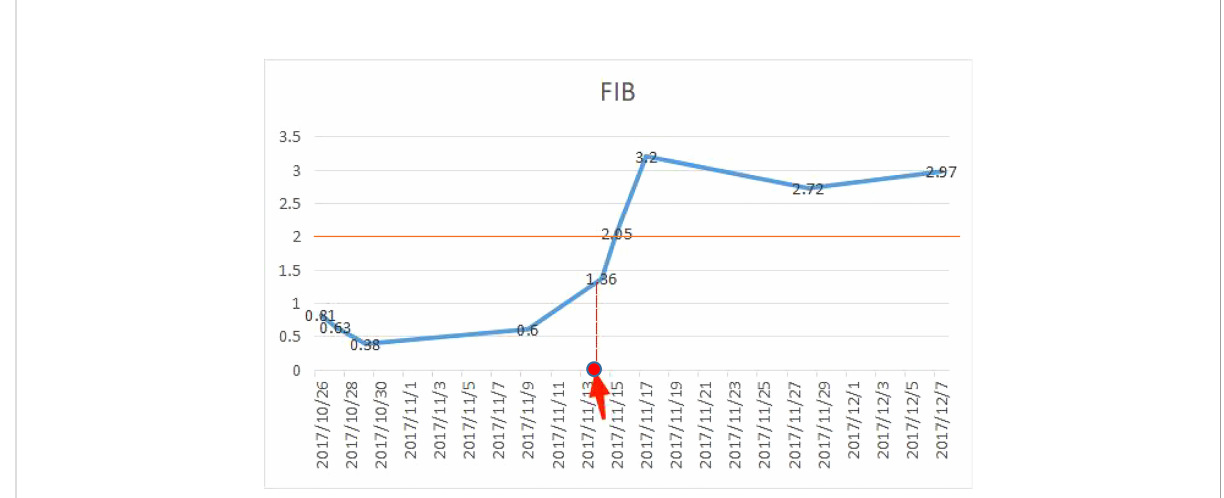
FIGURE 3 Fibrinogen was signi fi cantly reduced before surgery. On November 14, 2017, the hematoma was removed and hemostasis was performed, and the fi brinogen gradually returned to normal after surgery (normal value of fi brinogen: 2 – 4